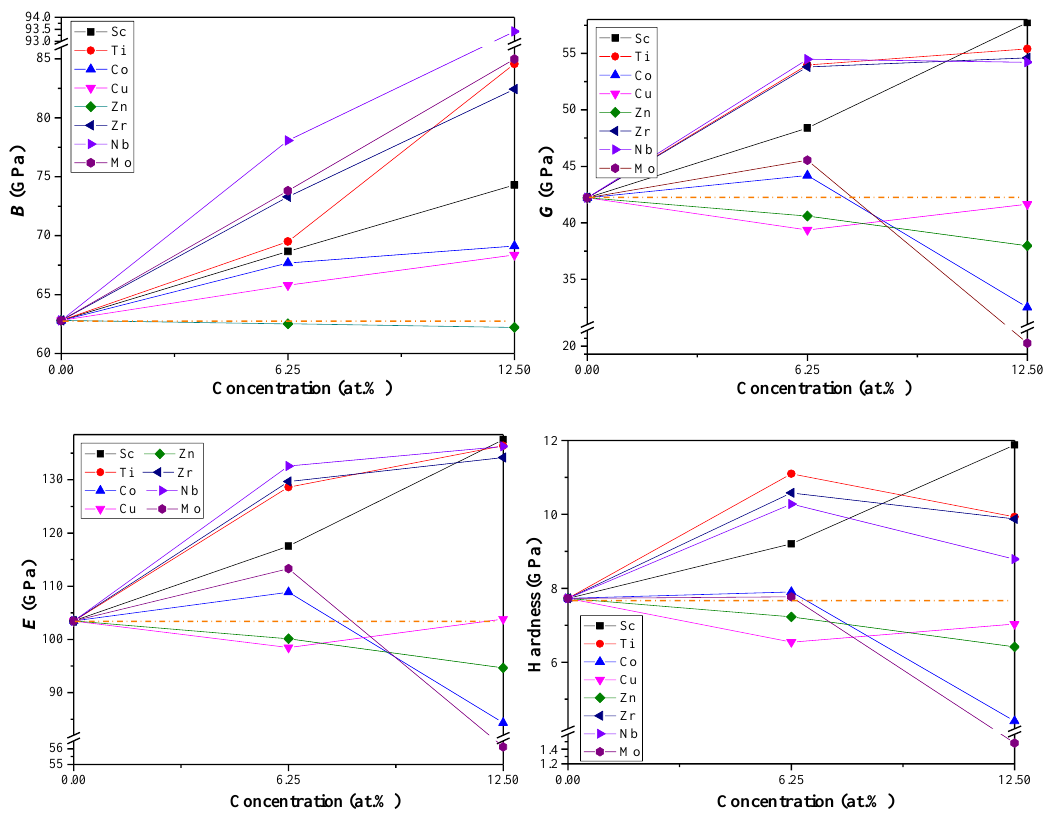
Figure 2. The predicted elastic moduli B , G , and E (GPa) and hardness H of Al 3 Li doped with alloying element X (X = Sc, Ti, Co, Cu, Zn, Zr, Nb, and Mo).